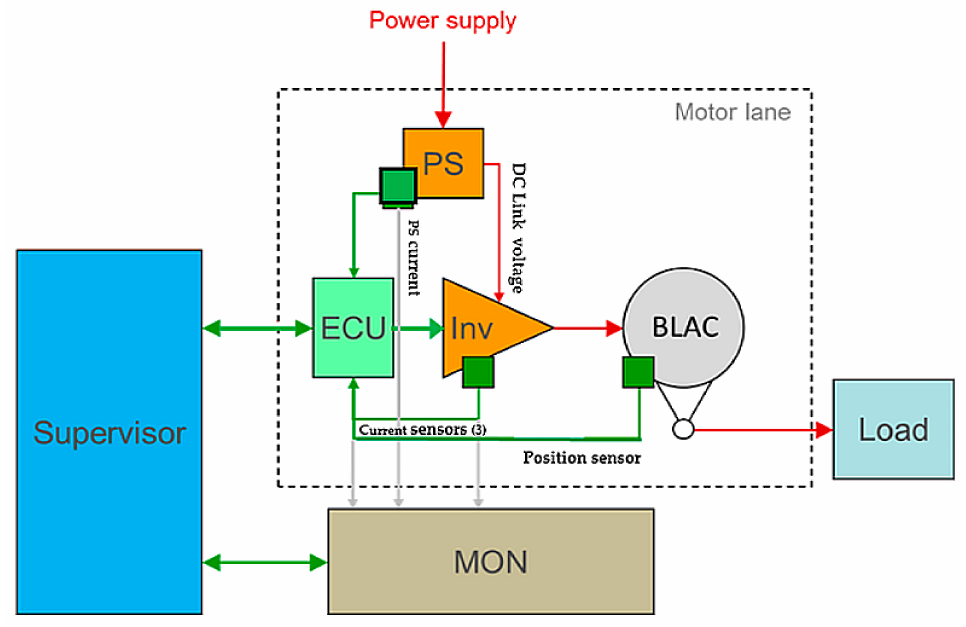
Figure 8. Control strategy of each brushless alternative current (BLAC) motor, ECU: Electronic Control Unit, Inv: Inverter, MON: Monitor, PS: Power